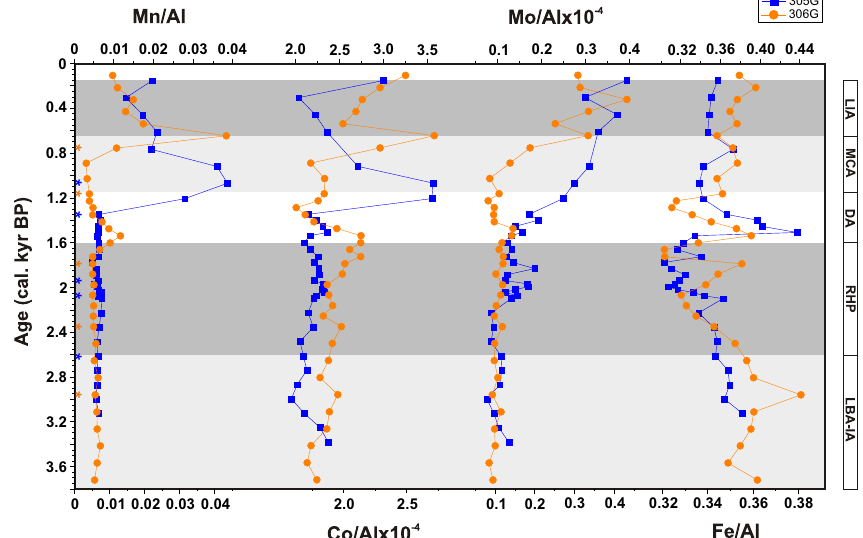
Fig. 9. Age-depth profile of post-depositional proxies (Co/Al and Mo/Al × 10 − 4 , Mn/Al and Fe/Al) for cores 305G (blue squares) and 306G (orange circles). Light grey bars indicate dry periods (MCA: Medieval Climate Anomaly, DA: Dark Ages, LBA-IA: Late Bronze Age-Iron Age); dark grey bars indicate humid periods (LIA: Little Ice Age, RHP: Roman Humid Period). Asterisks indicate the AMS 14 C